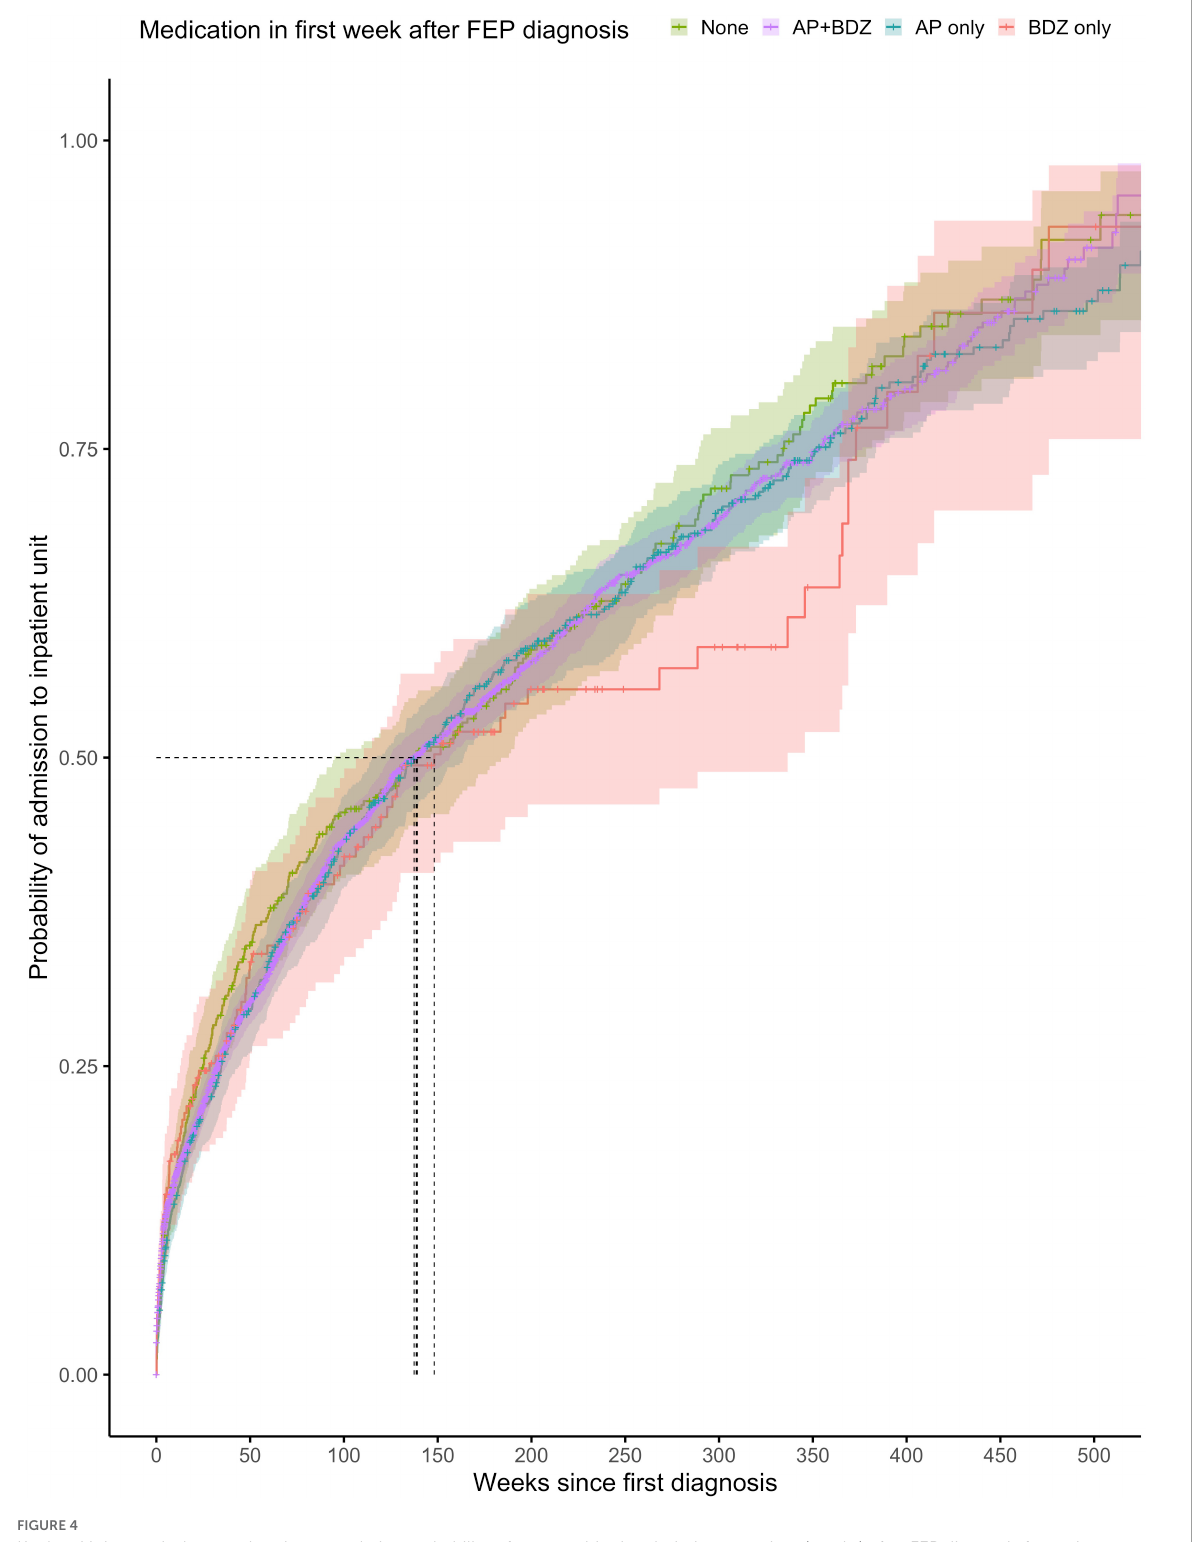
FIGURE4 Kaplan-Meier survival curve showing cumulative probability of any psychiatric admission over time (weeks) after FEP diagnosis for patients prescribed with no medication, combination of antipsychotics and benzodiazepines or antipsychotics alone or benzodiazepines alone within the first week after FEP diagnosis. Greenwood 95% confidence intervals are displayed for each curve. The dashed lines indicate the median time to admission in each